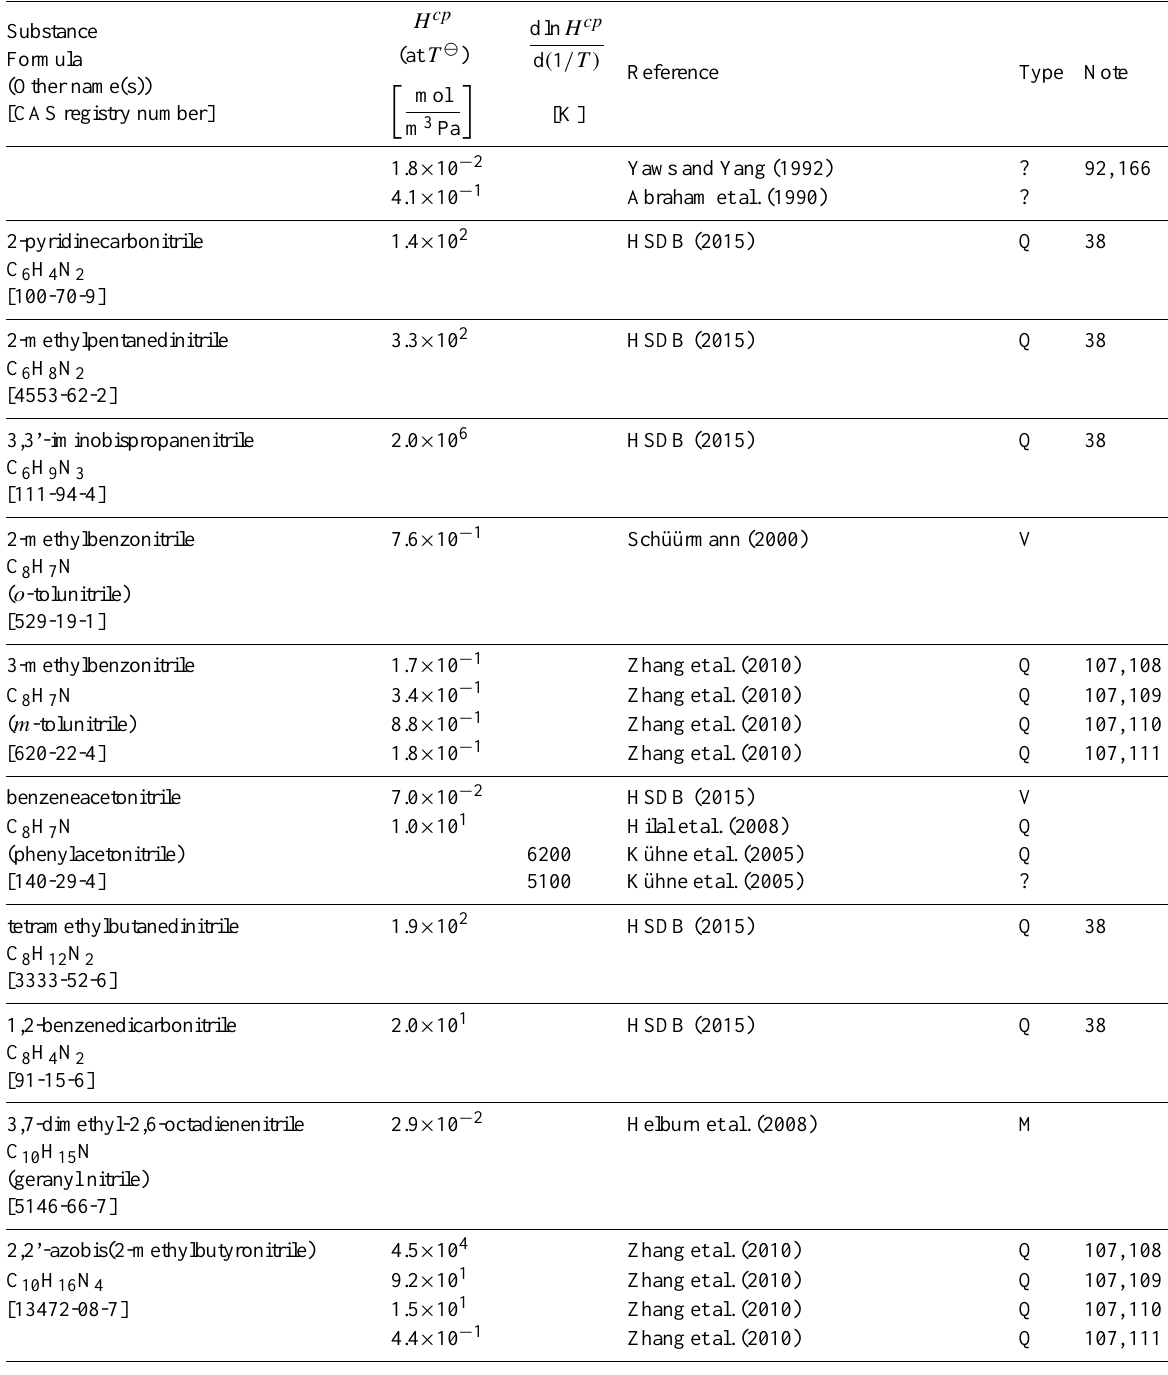
Table 6: Henry’s law constants for water as solvent